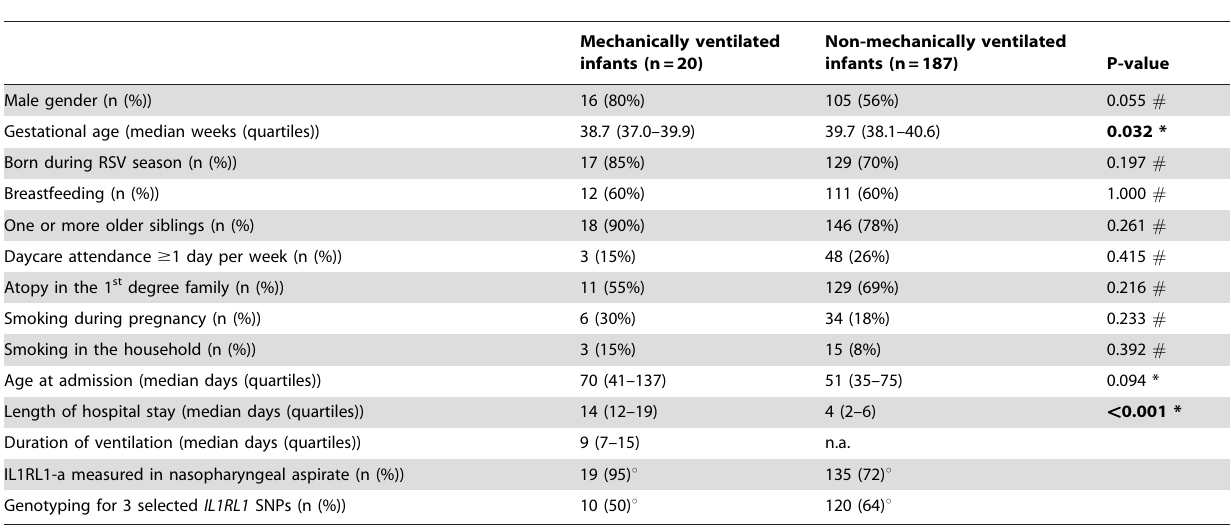
Table 3. Subject characteristics of infants hospitalized for RSV bronchiolitis with IL1RL1-a measured in nasopharyngeal aspirate.